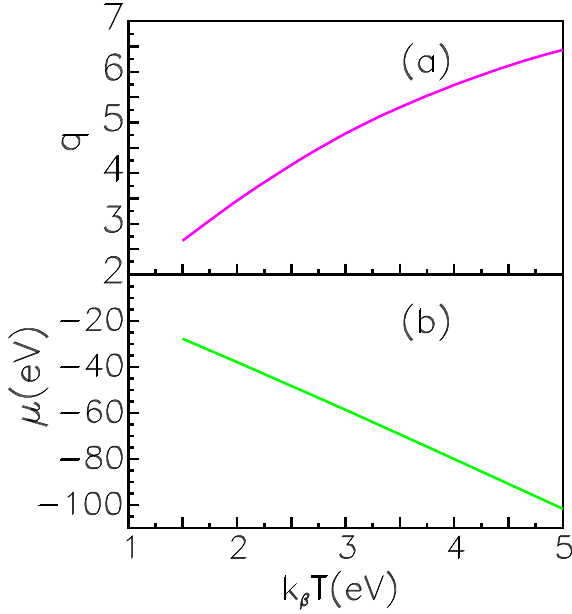
Figure 14. The charge q ( a ) and the chemical potential µ ( b ) for the impurity tungsten ion in fusion